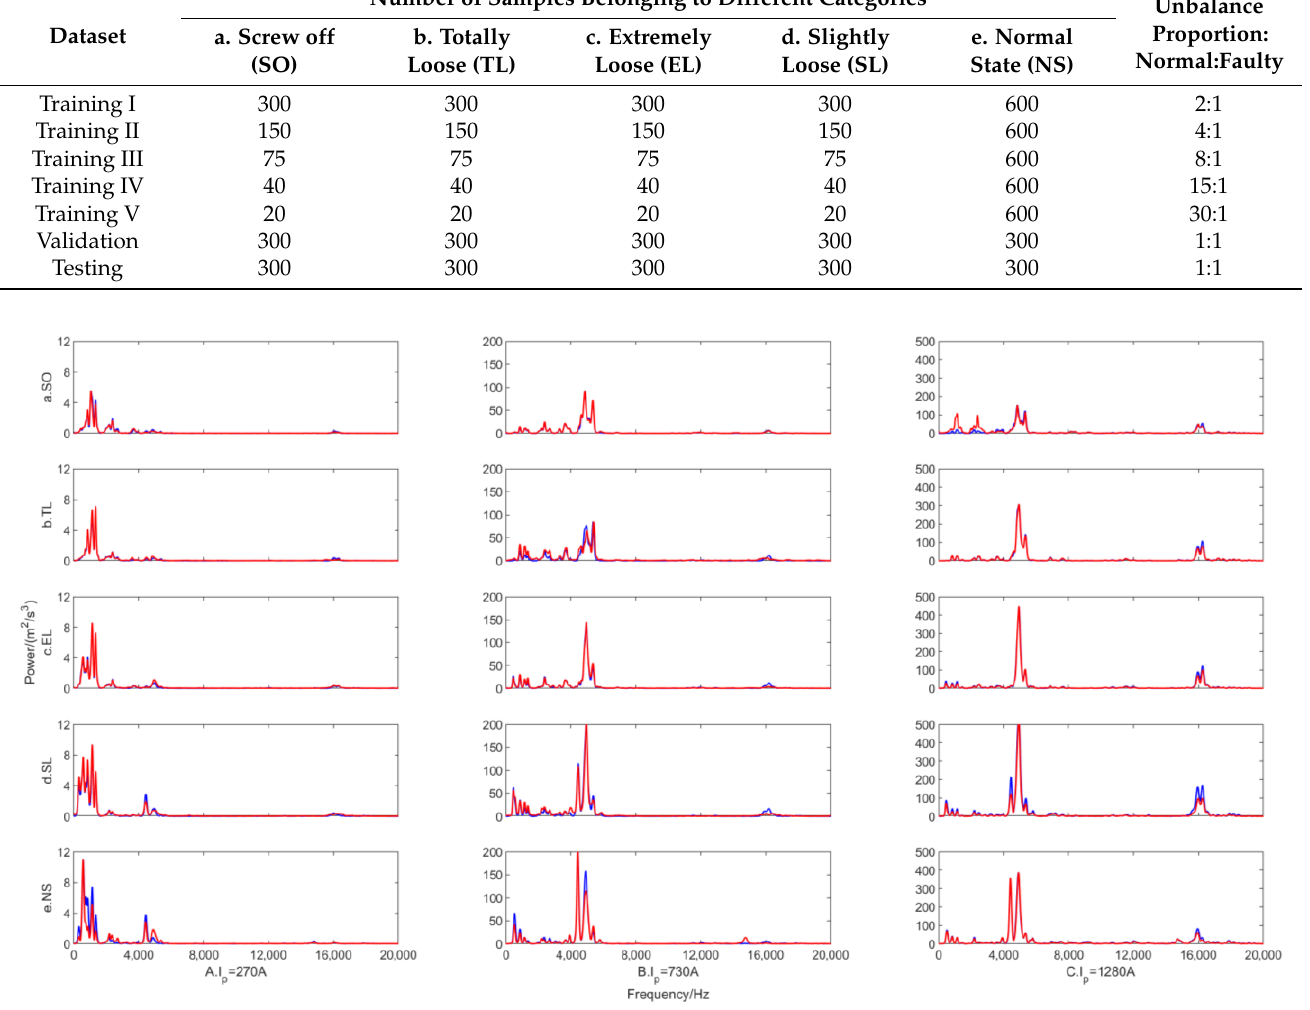
Figure 10. Power spectra of the original and generated samples. The blue line represents the real sample, and the red line represents the generated sample. From top to bottom, a~e represent the five iron core looseness faults in Table 4. From left to right, A, B, and C represent that the current peak values are 270 A, 730 A, and 1280 A, respectively.